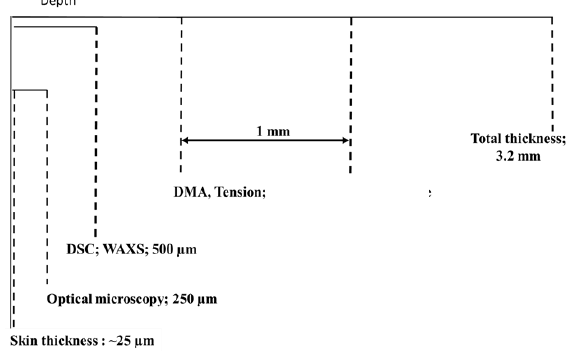
Figure 3. Sampling and characterizations within the thickness.